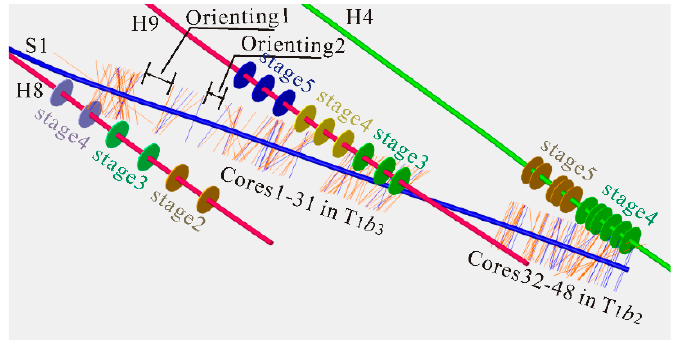
Figure 14. Perspective view of hydraulic fractures along the core wellbore and perforation clusters in the infield-scale in three-dimensional space.